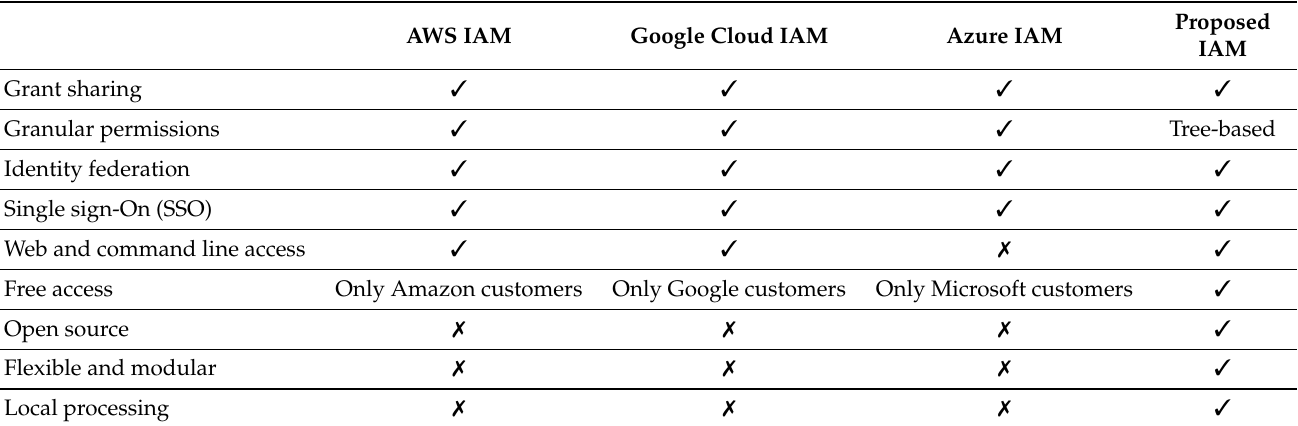
Table 1. Comparison of different IAM tools ( (cid:51) and (cid:55) means that the IAM presents or not present the feature, respectively).